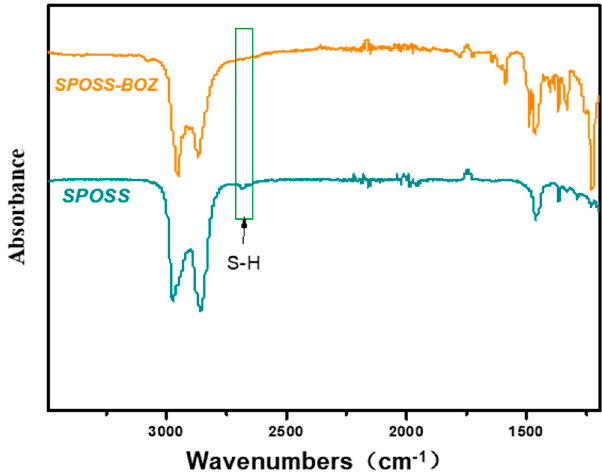
Figure 4. FTIR spectrum of SPOSS and SPOSS-BOZ.